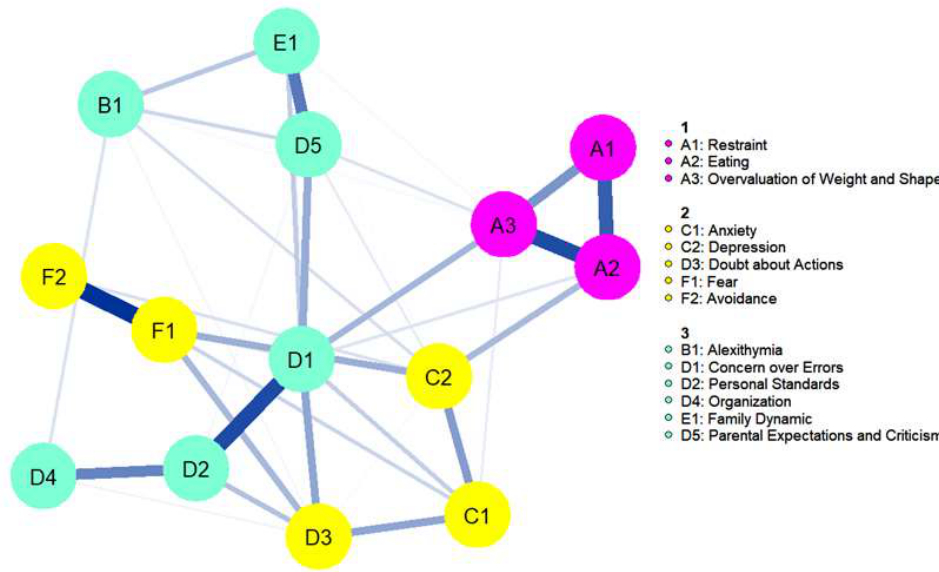
Figure 5. Network plot with bridge clusters. Nodes are represented as circles, color coded for each community (1: core eating disorder symptoms, 2: negative affectivity, 3: cognitive and socio-affective symptoms). Blue lines between nodes represent a positive association; thicker lines correspond to stronger associations.